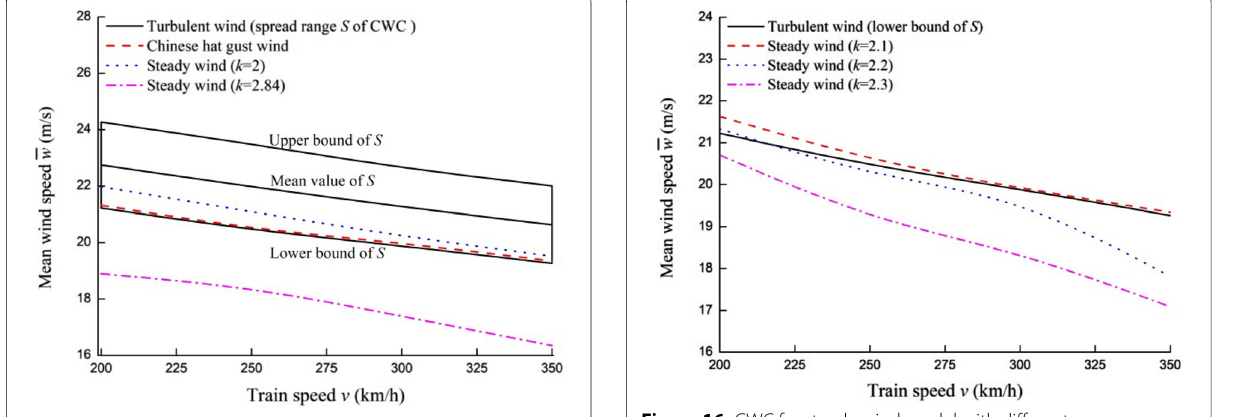
Figure 15 CWC for the three wind models Figure 16 CWC for steady wind model with different assurance